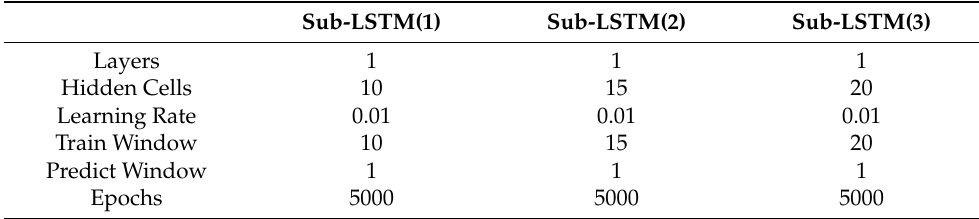
Table 3. Hyperparameter